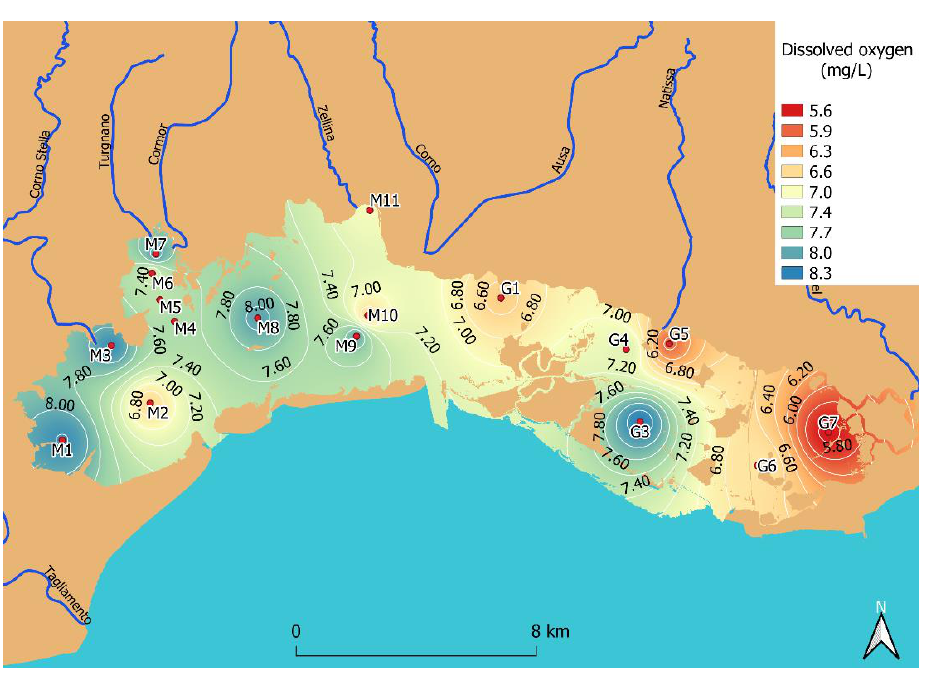
Figure 6. Spatial distribution of DO (mg L −1 ) (average of all collected data from 2013 to 2020) obtained by IDW (Inverse Distance Weighted) interpolation.